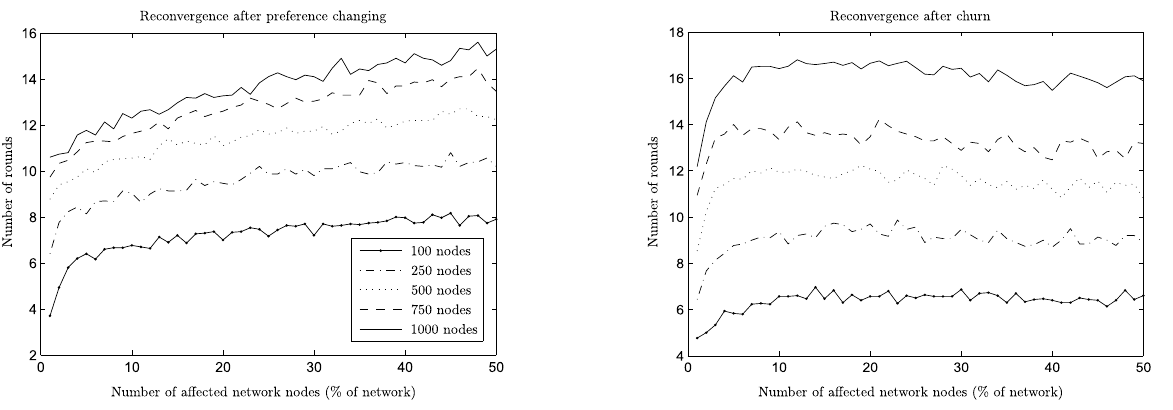
Figure 7. Reconvergence speed for preference change and churn